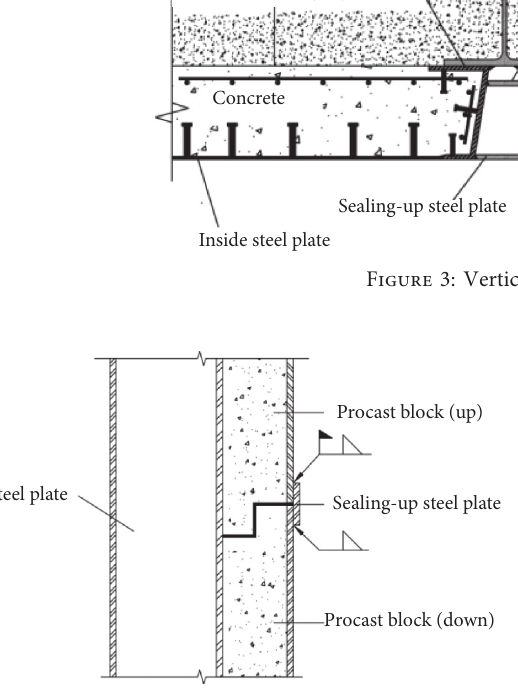
Figure 4: Circumferential joints of composite